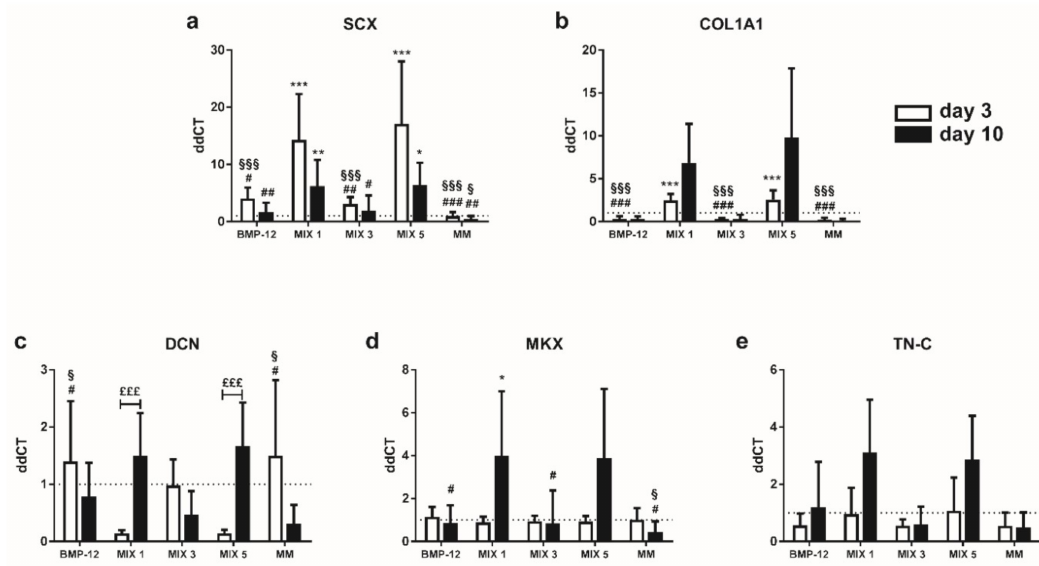
Figure 4. Expression of tendon-specific markers by TCs at 3 and 10 days after tenogenic induction. Expression levels of ( a ) SCX ; ( b ) COL1A1 ; ( c ) DCN ; ( d ) MKX and ( e ) TN-C , in TCs after tenogenic induction. Data are expressed as mean ddCT ± SD normalized to YWHAZ and CTRL sample. n =